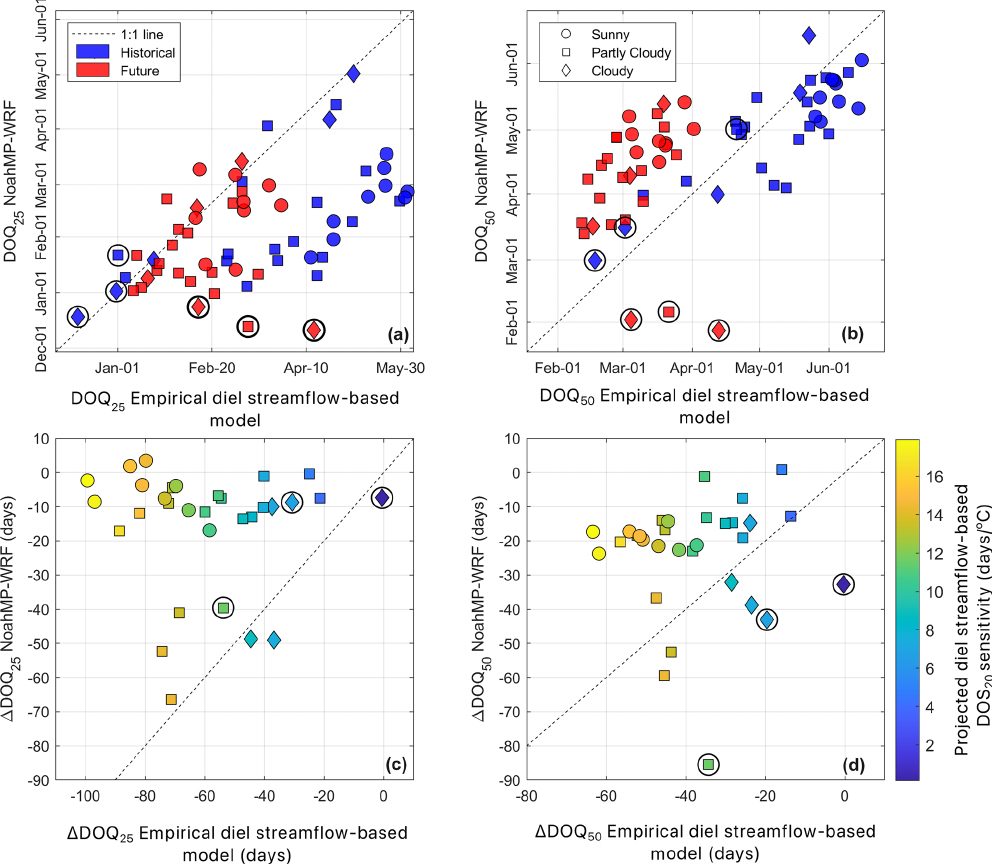
Figure 9. Changes to DOQ 25 and DOQ 50 due to climate change under a RCP8.5 pseudo global warming climate scenario by the end of the century. Panels (a) and (b) compare historical against projected values between NoahMP-WRF and the empirical diel streamflow-based model. Panels (c) and (d) compare the projected change in streamflow timing (future minus historical) between NoahMP-WRF and the empirical diel streamflow-based model, colored by the sensitivity of DOS 20 to climate change as projected by the empirical diel streamflow- based model (Fig. 8b). Symbols surrounded by black circles indicate sites that were excluded from the regression analysis in Fig. 5 (rainier site ID 24, 25, and 31). Symbols represent the historical mean annual percentage of clear-sky snowmelt days, where sunny sites (circles) have > 90% clear-sky snowmelt days, partly cloudy sites (squares) have between 70% and 90%, and cloudy sites (diamonds) have < 70%; clear-sky snowmelt days are defined as those with more than 80% of the potential clear-sky solar radiation. We make no inference about the cloudiness condition of snowmelt days under the RCP8.5 climate scenario; however, red symbols (upper panels) follow the same symbology for easier